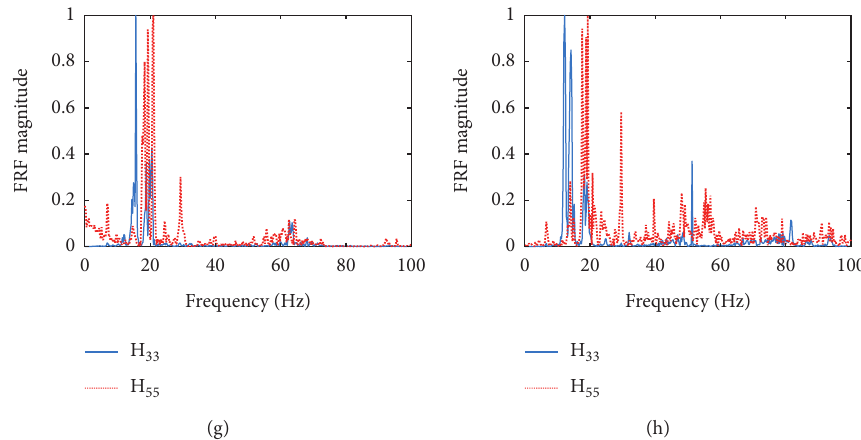
Figure 12: Normalized FRFs measured at A3 and A5 locations with the progression of damage: (a) undamaged, (b) 0.35%, (c) 0.5%, (d) 0.75%, (e) 1%, (f) 2%, (g) 2.5%, and (h) 3.2% drift ratios.